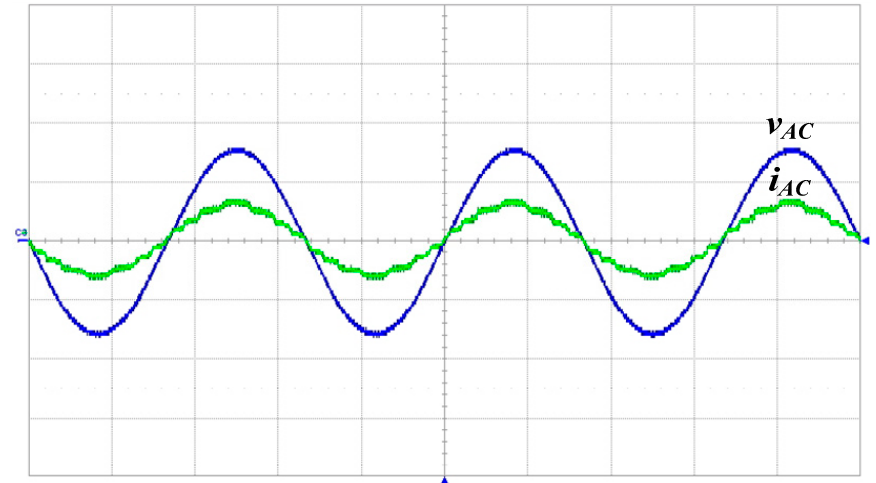
Figure 14. Measured input utility-line voltage v AC (200 V/div) and current i AC (2 A/div); time scale: 5 ms/div.